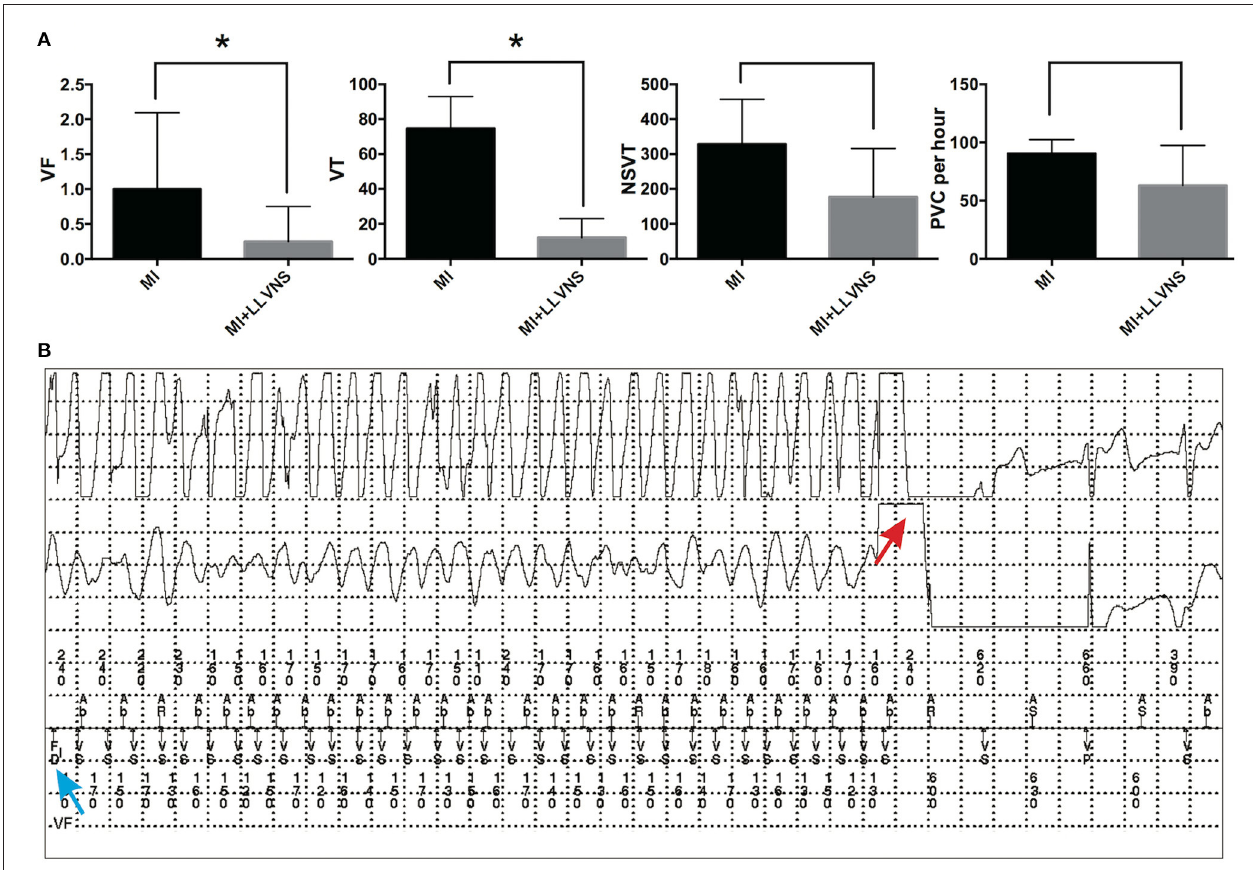
FIGURE 2 | The occurrence of VAs in the MI and MI + LLVNS groups. (A) The occurrence of VF, VT, NSVT, and PVC between the MI group ( n = 6) and the MI + LLVNS group ( n = 5) (* p < 0.05). (B) Example of an IEGM of ventricular fibrillation detected by the ICD and terminated by an ICD shock. The blue arrow shows the VF detected; the red arrow indicates the shock by the device, which restores the sinus rhythm. VAs, ventricular arrhythmias; VF, ventricular fibrillation; VT, ventricular tachycardia; NSVT, non-sustained ventricular tachycardia; PVC, premature ventricular contraction; ICD, implantable cardioverter defibrillators; LLVNS, low level left vagus nerve stimulation; MI, myocardial infarction.